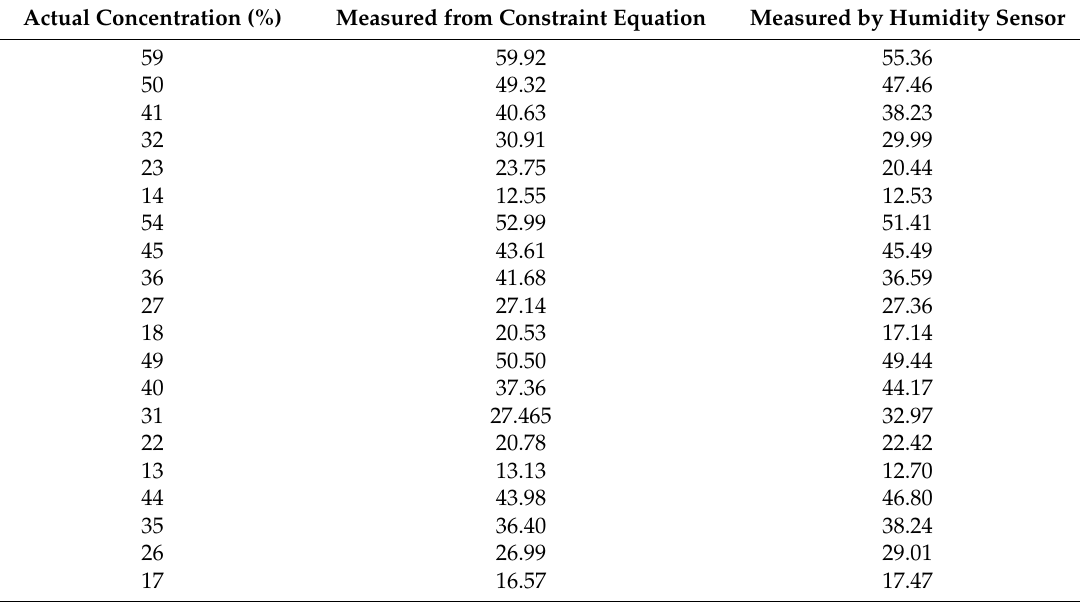
Table 2. Calibration concentrations of